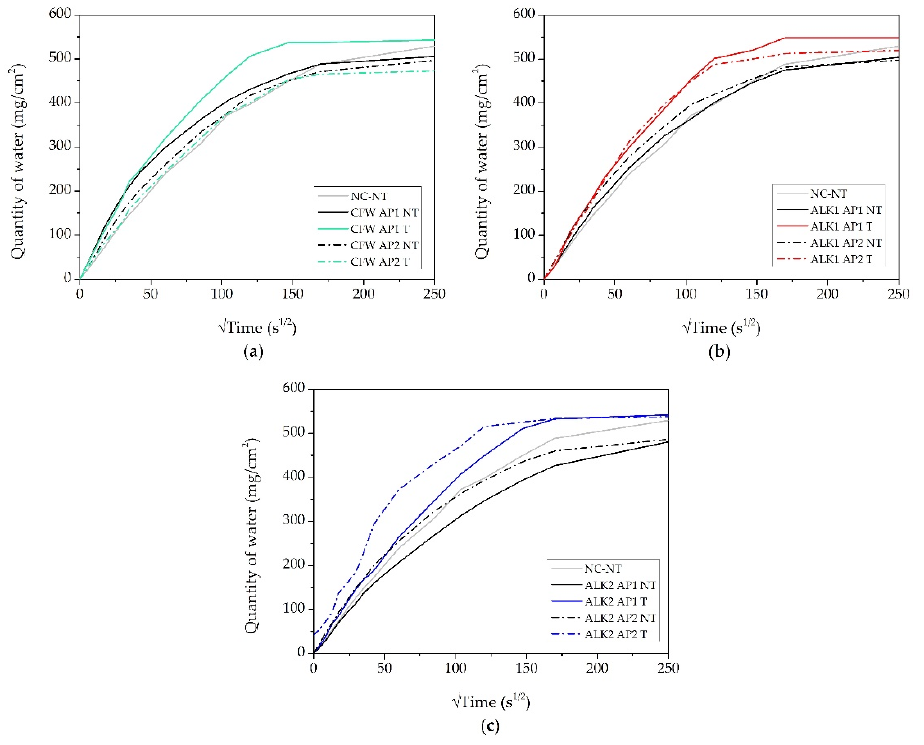
Figure 7. Quantity of water absorbed by capillarity–comparison among uncracked–untreated samples (NC–NT), cracked–untreated samples (CFW_AP1 NT, CFW_AP2 NT, ALK1_AP1 NT,